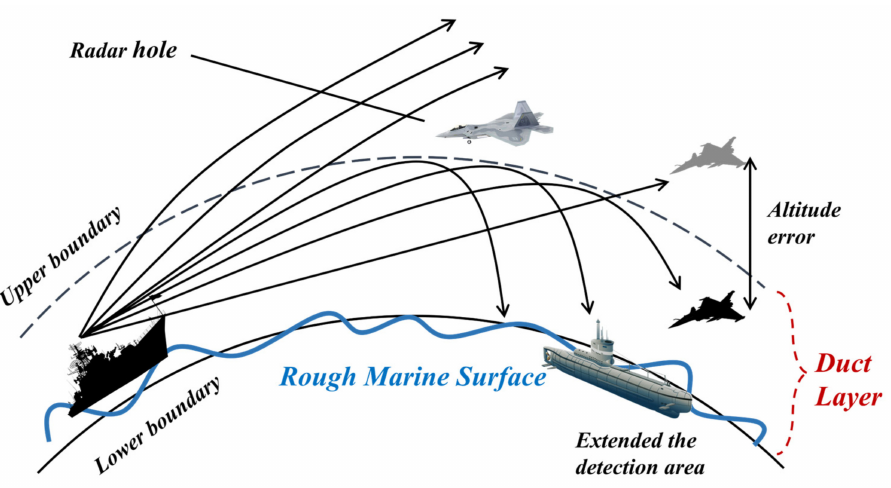
Figure 1. Main effects of a marine TD on radar